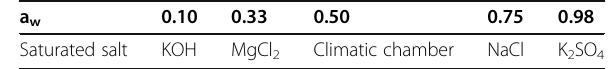
Table 3 A w of saturated salts used to test sorption behavior of MPPs